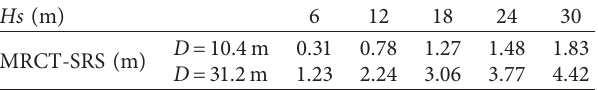
Table 4: MRCT-SRS for the metro tunnel.